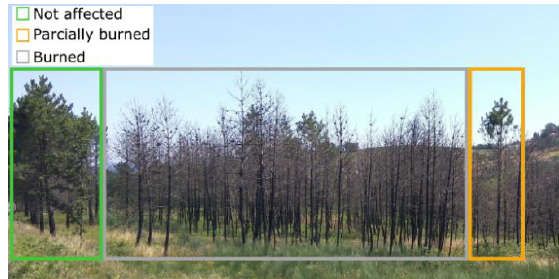
Figure 1. Different types of tree health condition considered in this study.